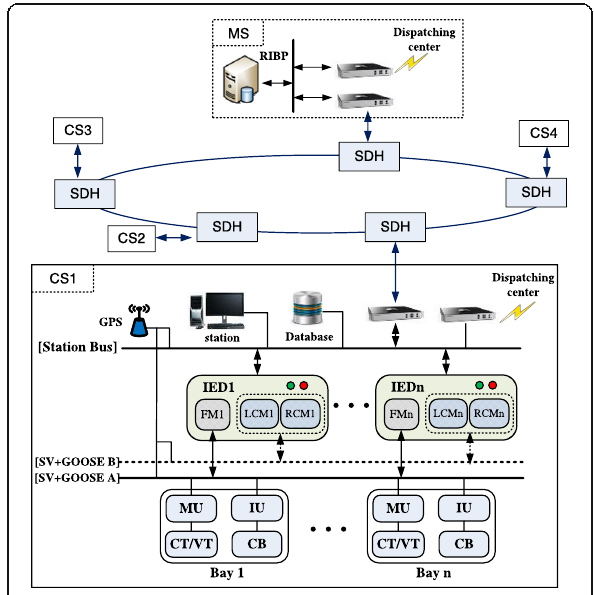
Fig. 1 Structure of coordinated backup protection